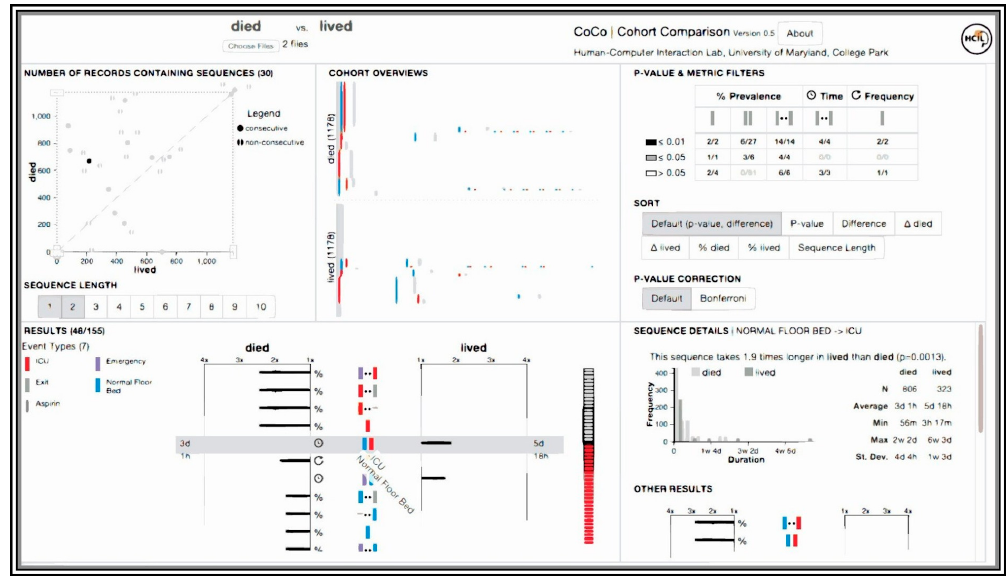
Figure 7. Caregiver: Interactive visualization tool for visualization of categorical and numerical data. Source: Image courtesy of Dominique Brodbeck.